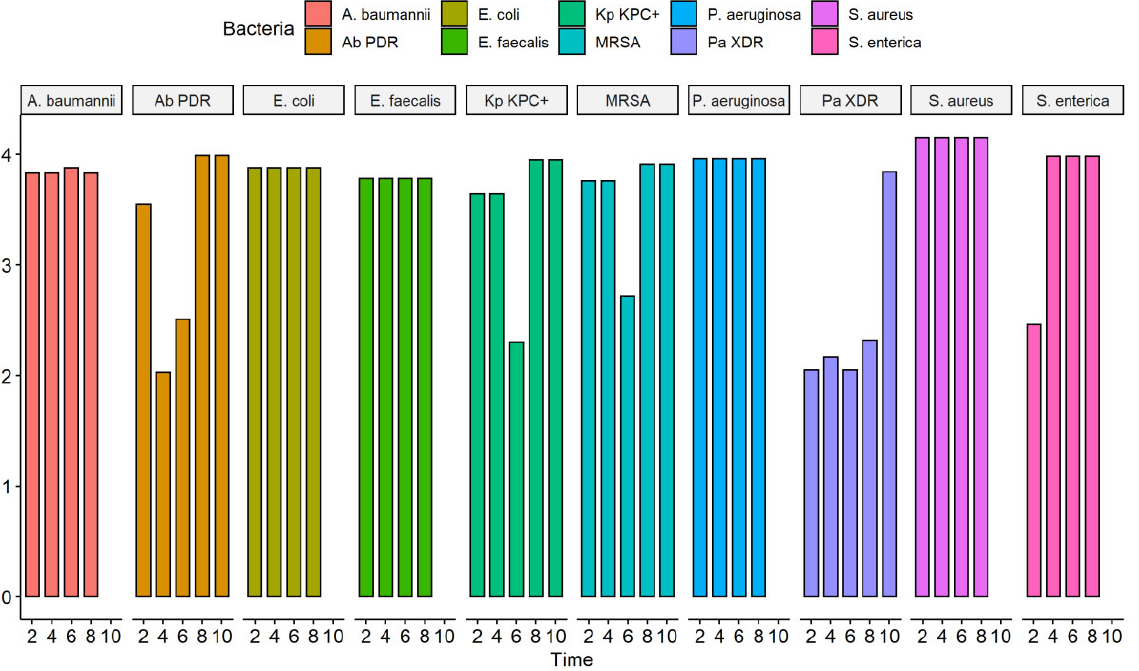
Figure 5. Efficacy of the UV-C system in reducing several bacterial strains expressed in log 10 reduction of CFU/mL; CFU, colony forming units; A. baumannii , Acinetobacter baumanni ; Ab PDR, Acinetobacter baumannii Pandrug-resistant; E. coli , Escherichia coli ; E. faecalis , Enterococcus faecalis ; Kp KPC+, Klebsiella pneumoniae produtora de carbapenemase (KPC+); MRSA, Staphylococcus aureus resistente à meticilina; P. aeruginosa , Pseudomonas aeruginosa ; P. aeruginosa XDR, Pseudomonas aeruginosa, Extensively drug-resistant; S. aureus , Staphylococcus aureus ; S. enterica , Salmonella enterica.